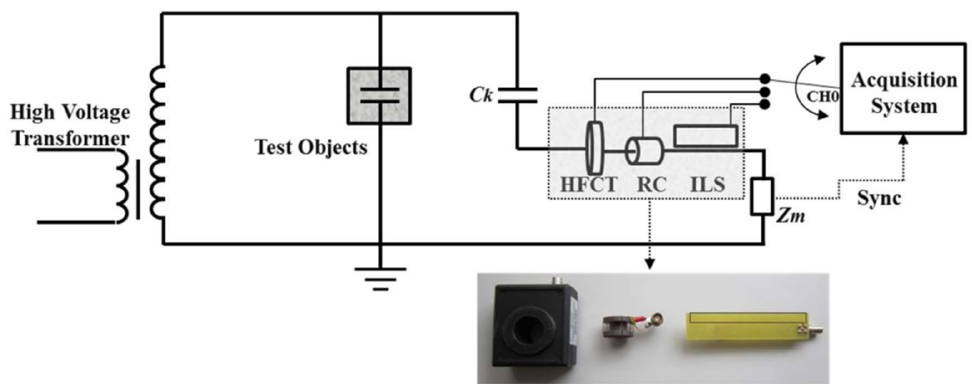
Figure 9. Experimental setup and location of the three sensors to record the partial discharge by [89].